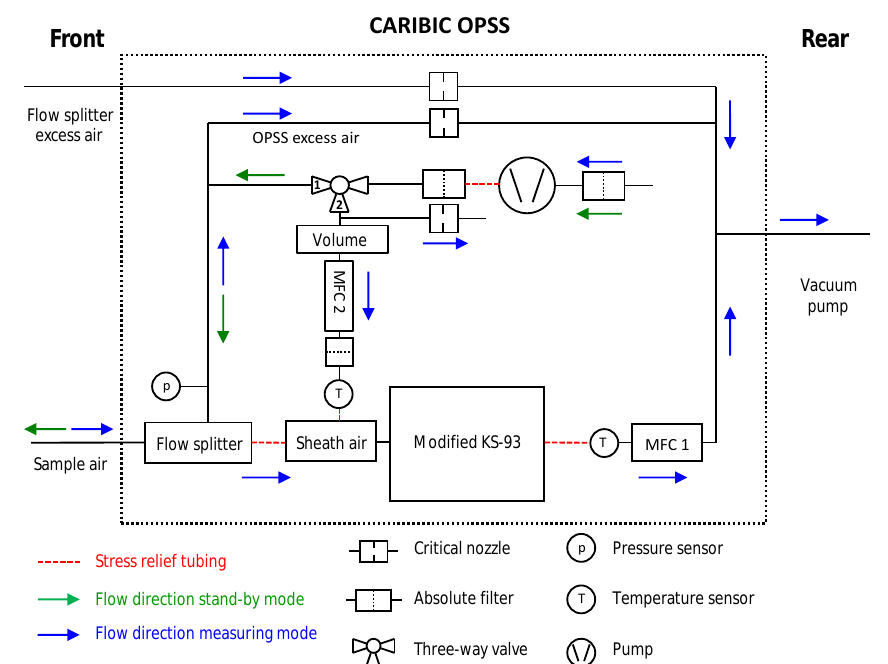
Figure 2. Air flow diagram of the CARIBIC OPSS.